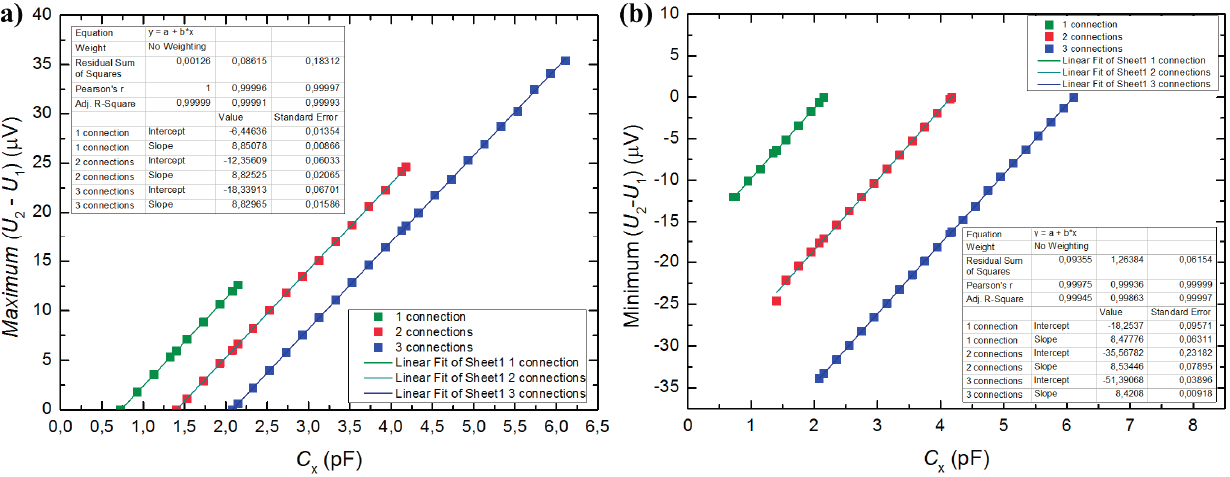
Figure 5. ( a ) Expected maximum output voltage variation, with oil as continuous phase; ( b ) Expected minimum output voltage variation, with water as continuous